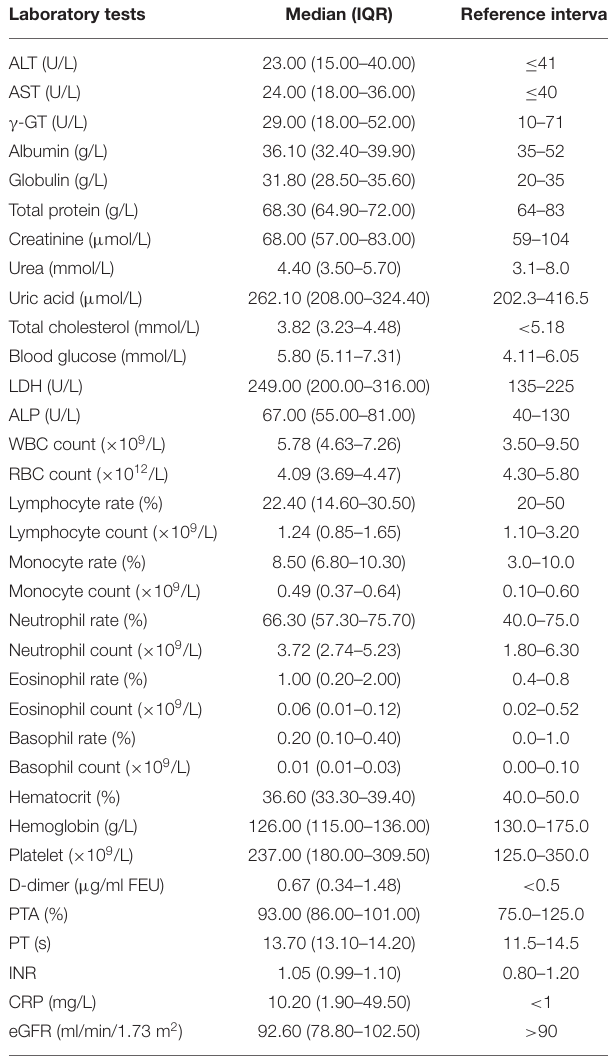
TABLE 1 | Demographic characteristics, hospitalization days, and outcomes of 1,035 COVID-19 patients.